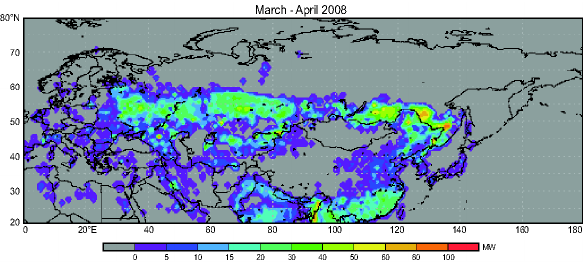
Figure 5. Snow accumulation as a function of time (monthly averages) for three East Siberian sites used in this study. Note that the Yakutsk depths are estimate based on climatology scaled linearly by the measured total depth. The other site data are direct measurements for the 2007-8 accumulation season.